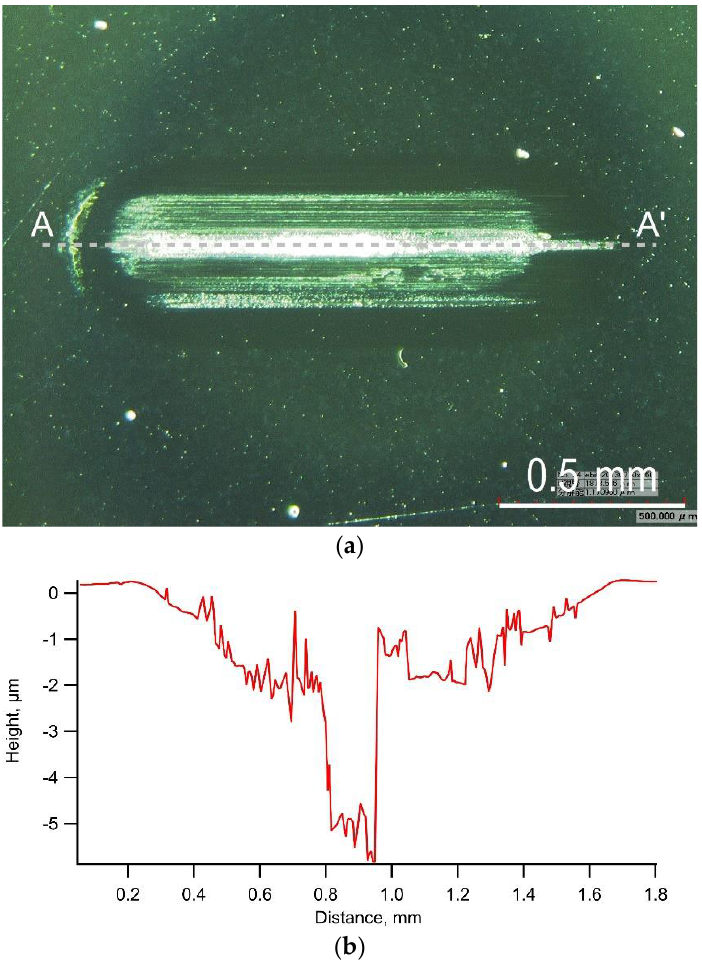
Figure 4. Typical example of the appearance of wear scar and its cross-section shape observed in the test using a-C film: ( a ) Appearance of wear scar on test plate, ( b ) Cross-section shape along A-A’.